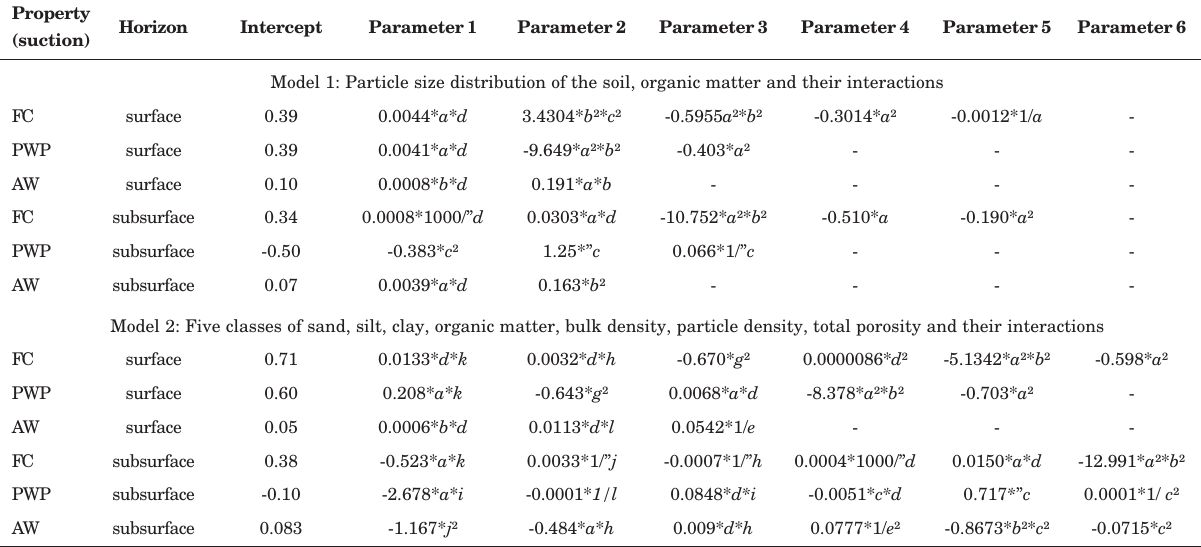
(1) a : sand content (kg kg -1 ); b : silt content (kg kg -1 ); c : clay content (kg kg -1 ); d : organic matter content (g kg -1 ); e : bulk density (Mg m -3 ); f : particle density (Mg m -3 ); g: total porosity (m 3 m -3 ); obtained by the equation: g = 1-( e/2.65) ; h : very coarse sand content (kg kg -1 ); i : coarse sand content (kg kg -1 ); j : medium sand content (kg kg -1 ); k : fine sand content (kg kg -1 ); l : very fine sand content (kg kg -1